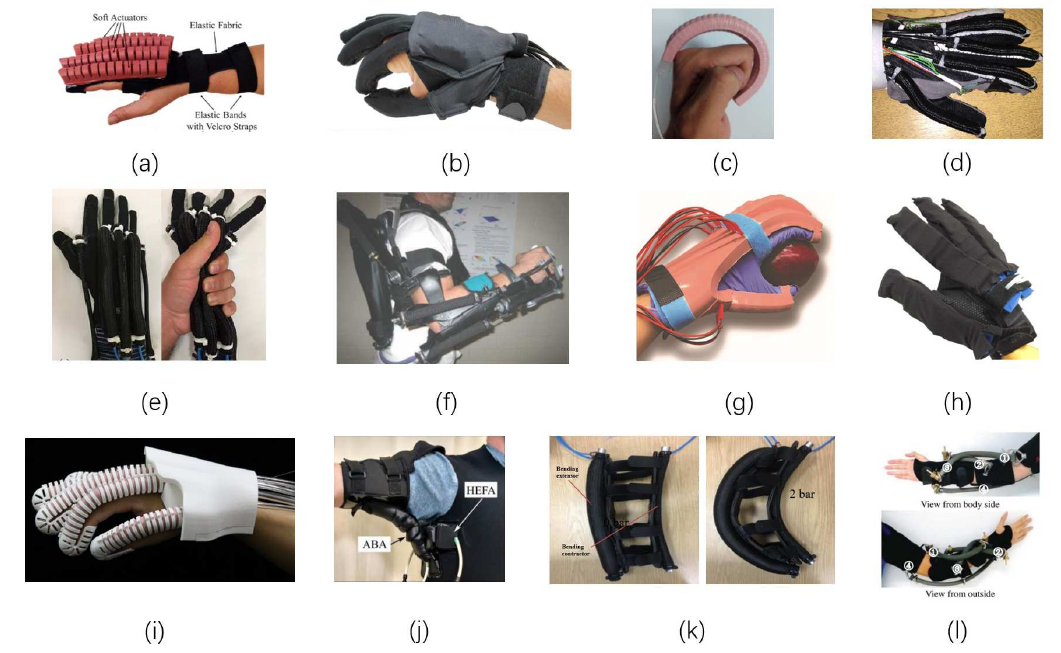
Figure 3. Soft rehabilitation and nursing-care robots based on pneumatic fiber braided fabrics and elastic polymers in upper limb. ( a – d ) is reprinted from [49,52,53,55], respectively. ( e – h ) is reprinted from [56–58,62], respectively. ( i – l ) is reprinted from [64,67–69], respectively.